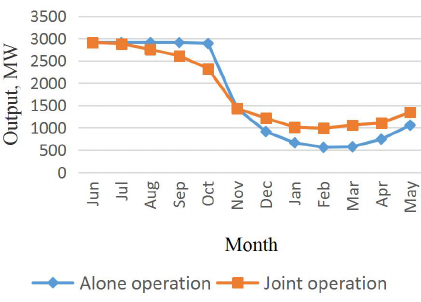
Figure 5. The output of plant C.